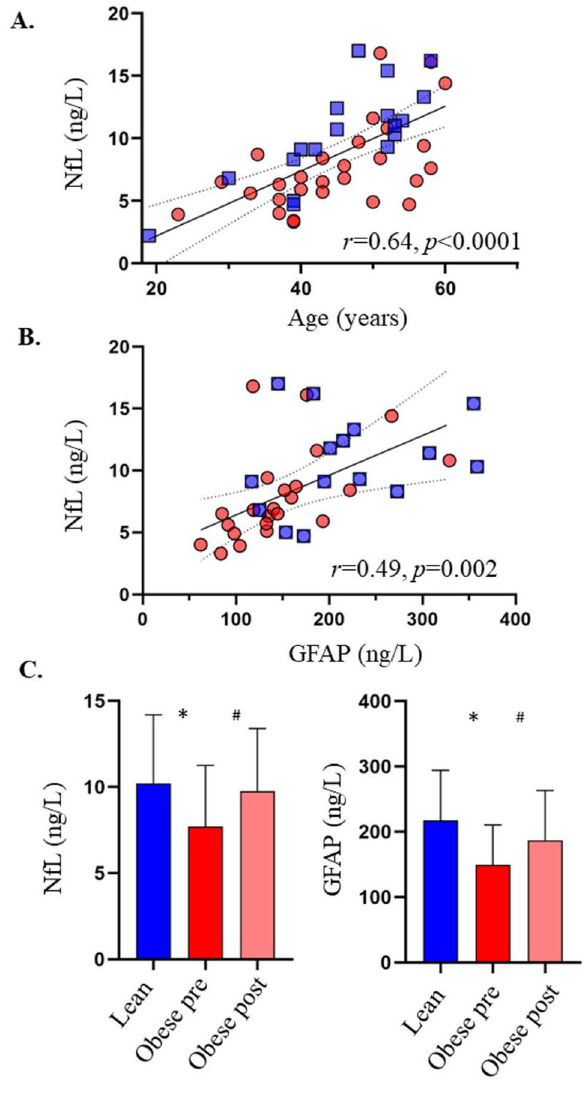
Figure 1. Plasma NfL levels correlated positively with age ( A ), and with GFAP concentrations ( B ). Plasma NfL and GFAP were higher in the lean as compared to the obese individuals, and increased 6-months post bariatric surgery ( C ). Red circles: subjects with obesity; blue squares: lean subjects. Light pink: obese subject post bariatric surgery. GFAP glial fibrillary acidic protein, NfL Neurofilament light